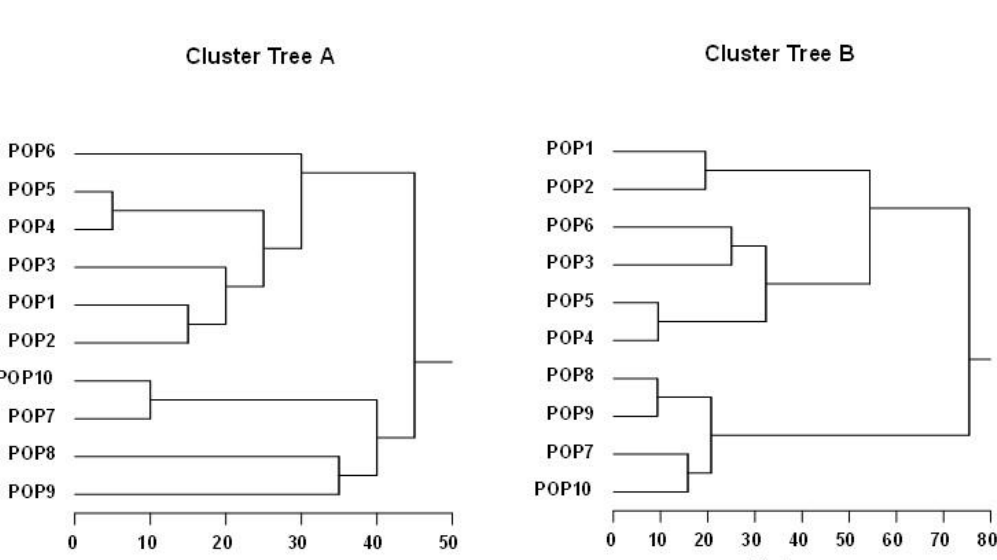
Figure 3. ( A ) Cluster analysis among ten populations ( Pop ) of A. javanica based on morphological characters. ( B ) Cluster analysis among ten populations of A. javanica based on ISSR molecular markers. Pop 1 = Ras Garib (Wadi Abo Had), Pop 2 = Hurghada (Wadi Bali), Pop 3 = Qena-Safaga Road (Wadi El-Markh), Pop 4 = Qeft-Qusseir Road (Wadi El-Matulli), Pop 5 = Qeft-Qusseir Road (Wadi El-Laqeita), Pop 6 = Qeft-Qusseir Road (El Fawakher), Pop 7 = Idfu-Mrsa Allam Road, Pop 8 = Idfu-Mrsa Allam Road Wadi Abbady (El-Timsah), Pop 9 = Idfu-Mrsa Allam Road Wadi Abbady (El-Timsah), Pop 10 = Idfu-Mrsa Allam Road Wadi Abbady (El-Kanayis).